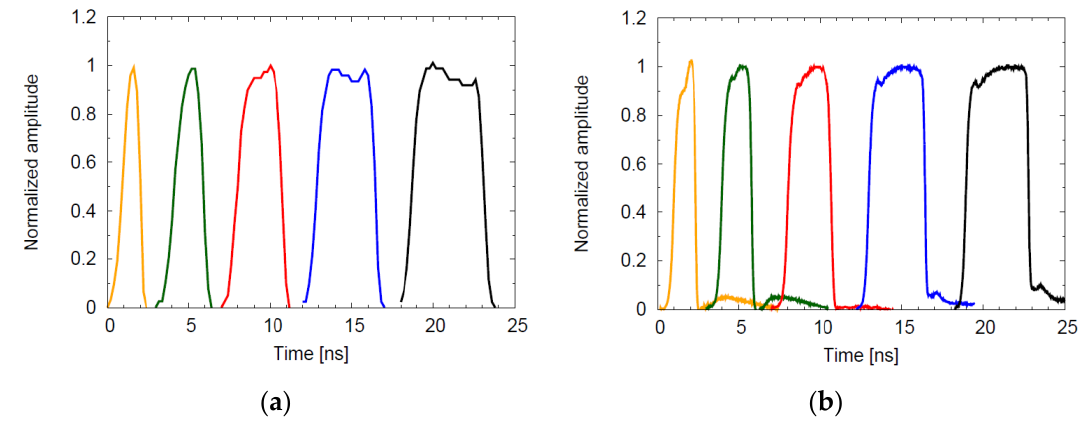
Figure 10. Pixel analog output histograms for the analog counting pixels of [19] and [36], depicted in ( a ) and ( b ), respectively.